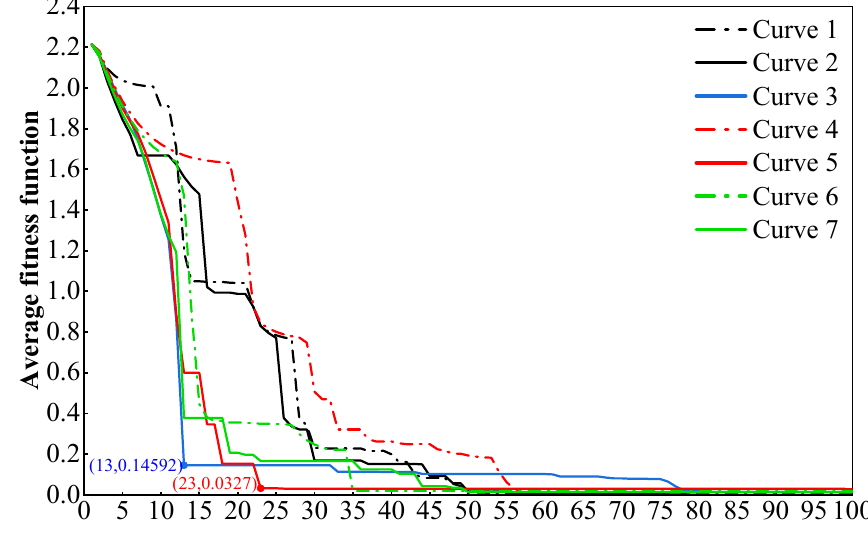
Figure 10. Diagram of average fitness values in Relation to initial values of learning factors c 1 and c 2.